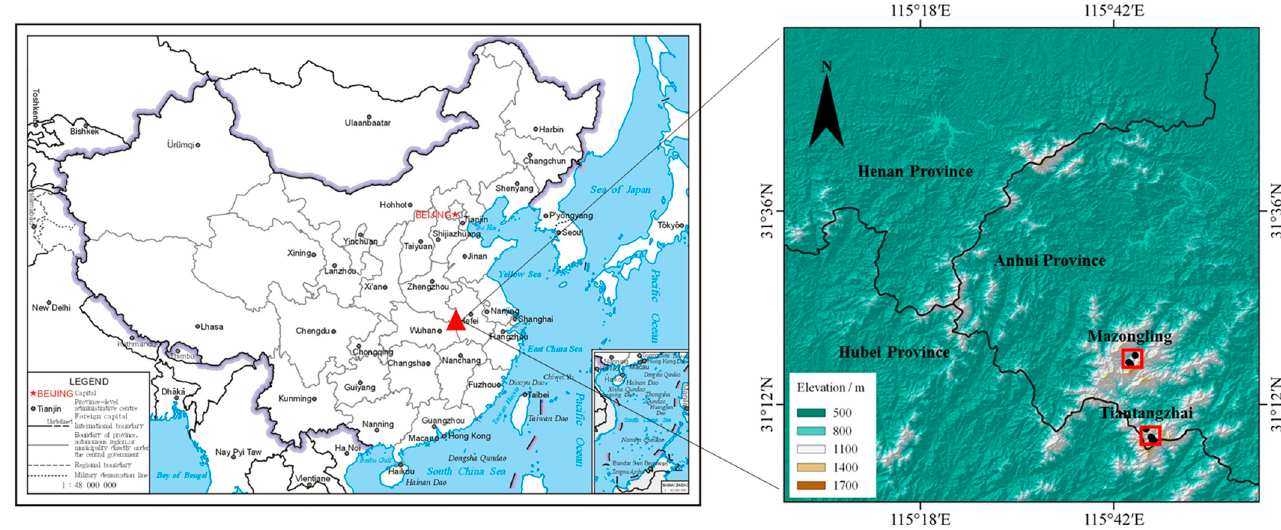
Figure 2. Locations of the study area and two sample sites of mountain ranges. The two sample sites (Tiantangzhai and Mazongling) stretch through the core area of the nature reserve.